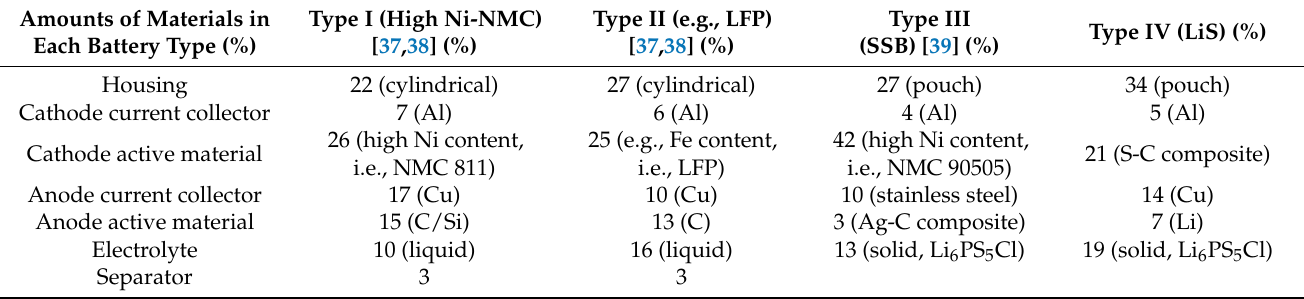
Table 1. Material contents of different battery generations (with a focus on lithium-based